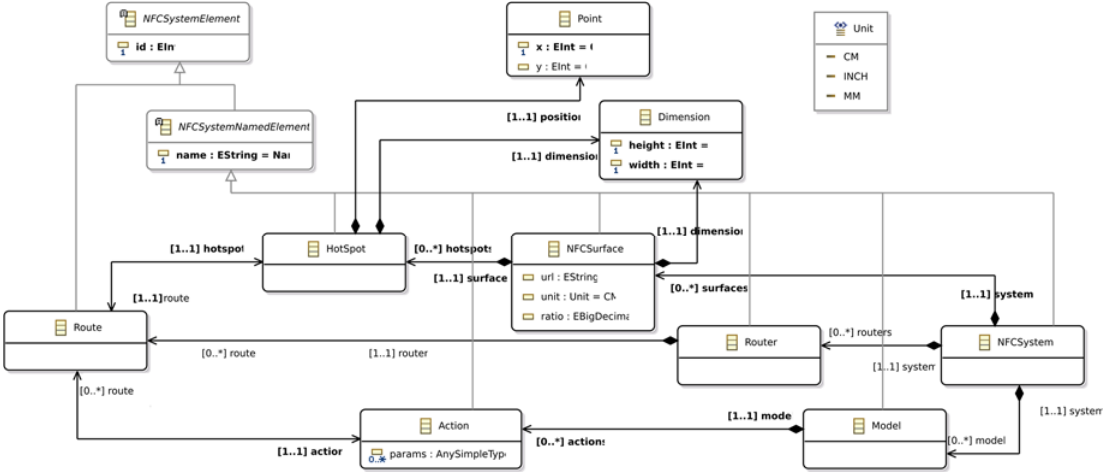
Figure 3. The Platform Independent Model point of view metamodel.